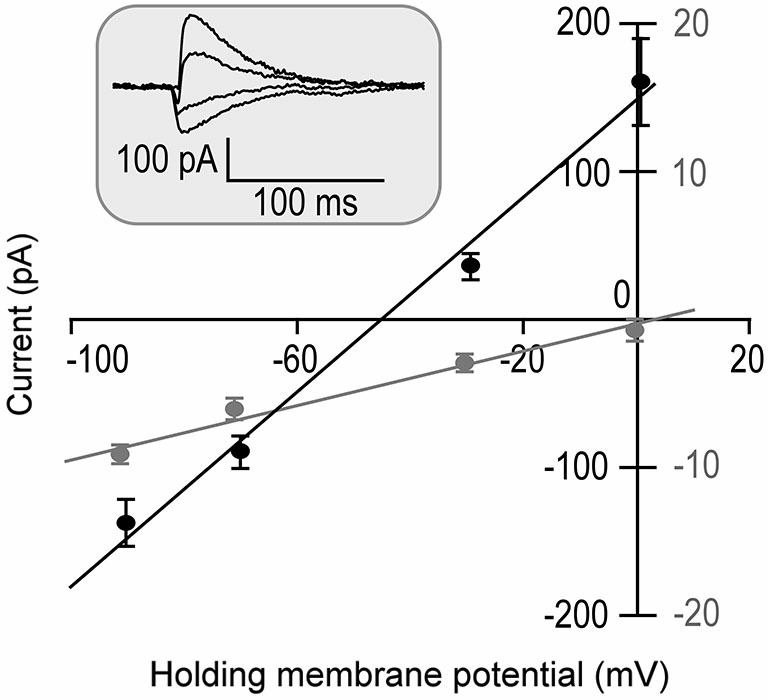
Tone-evoked postsynaptic currents (Inset) are plotted as the function of holding membrane potentials in one neuron (repeated 5 times). Since the IPSC commonly has a 1–4 ms delay from the EPSC (Wehr and Zador, 2003), two time windows of 0–1 ms (Gray symbols) and 5–7 ms (Black symbols) from the response onset were selected for EPSC and IPSC measurements. The postsynaptic currents were linearly correlated to the holding potentials (R2 = 0.98 and R2 = 0.99, respectively).